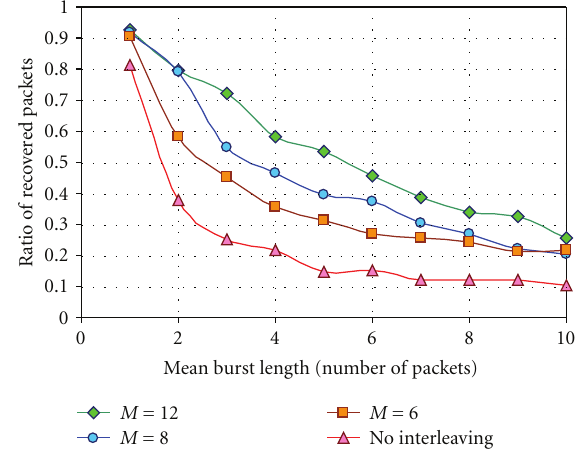
Figure 10: Recovered packets under the priority-encoded scheme for various global FEC group sizes M across a Bluetooth channel for various global FEC group sizes. “No Interleaving” includes built-in Bluetooth FEC within a